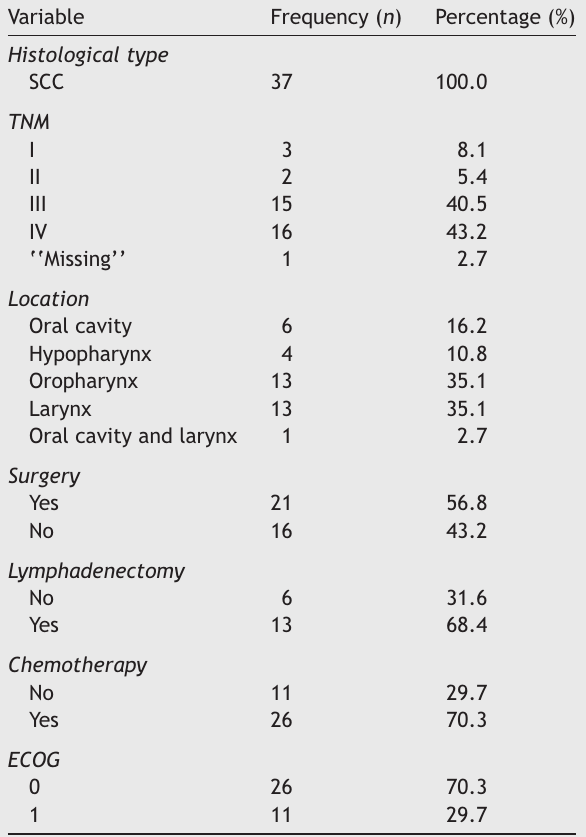
Clinical characteristics of patients participating